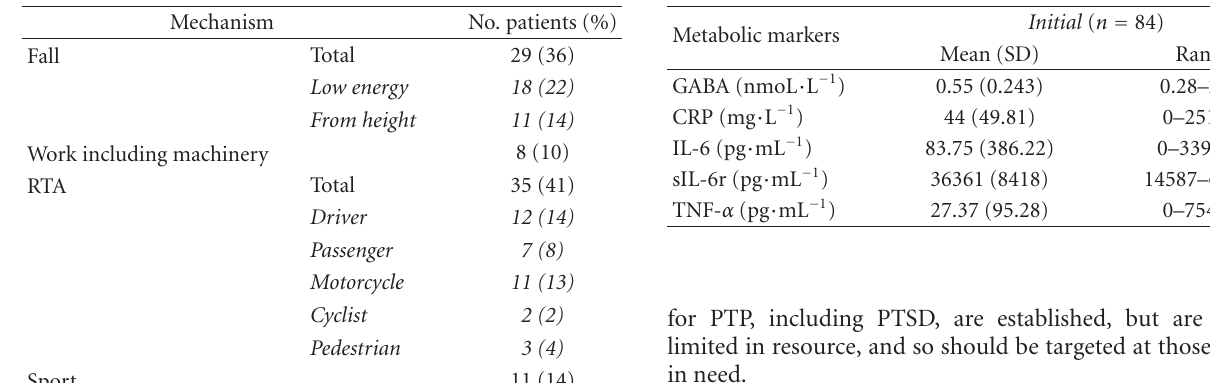
Table 1: Mechanism of injury (RTA = road tra ffi c accident). Table 2: Biological markers